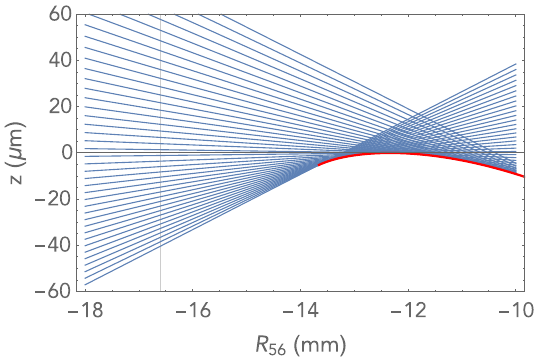
FIG. 14. Electron trajectories in z – R 56 space, and caustic expression [Eq. (8)] shown in red. The gray vertical line represents the value of R 56 where a linearly ramped current profile (along the z direction) can be